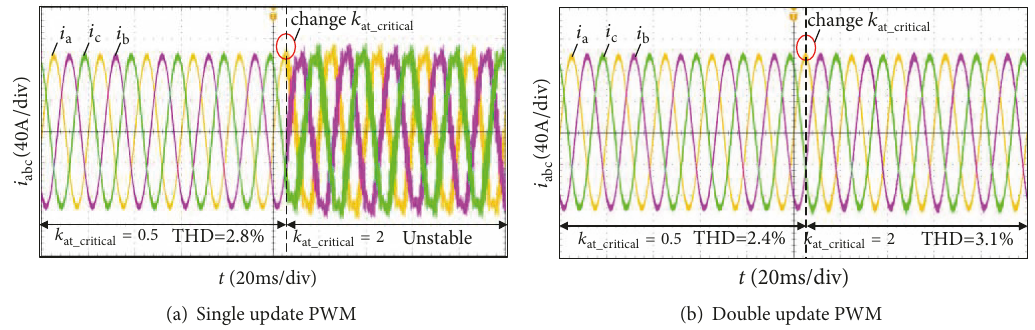
=1.5). at critical